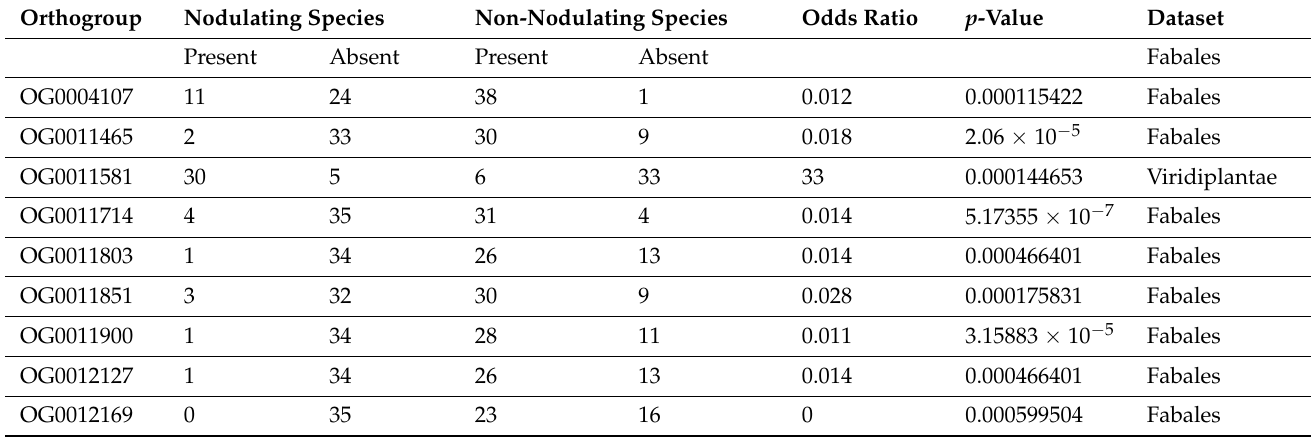
Table 3. Gene families differentially represented in nodulating and non-nodulating species. Pres- ence/absence analysis, Fisher Exact Test with Bonferroni correction. Dataset column indicates the mode of comparison: Fabales denotes nodulating Fabales vs. all other taxa (including non-nodulating legumes), Viridiplantae denotes all known nodulators among green plants vs. all non-nodulators.